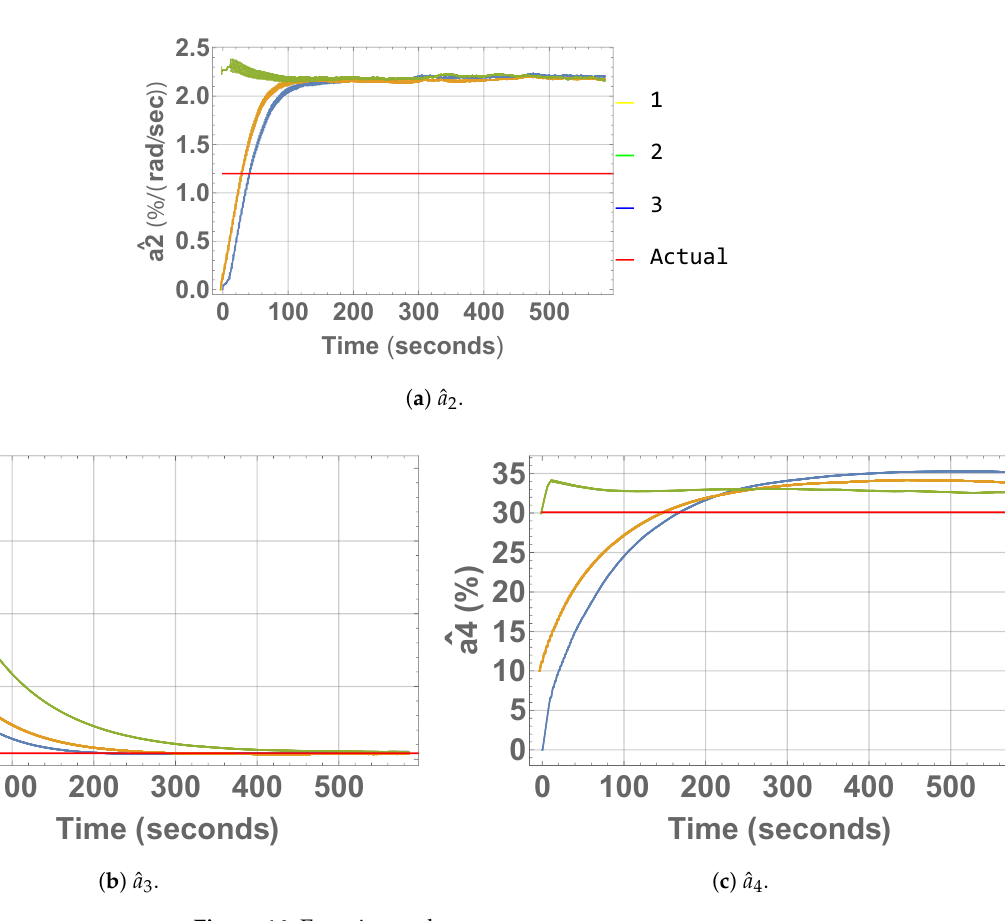
Figure 16. Experimental parameter